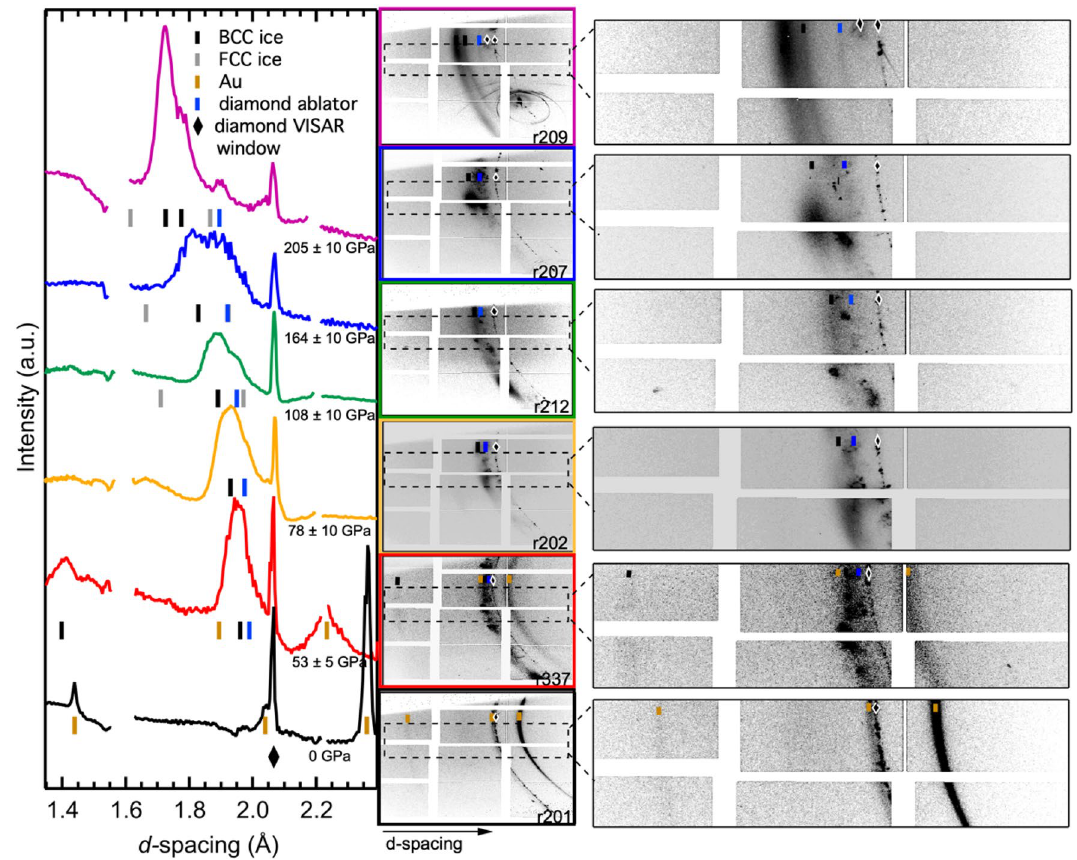
Figure 2. X-ray diffraction data with increasing pressure. Raw integrated traces from all high-pressure water shots without any normalization measured at ~ 7 ns for the highest pressures. Colored tick marks indicate fitted peak center for labeled phase. FCC ice positions are shown for reference to note where peaks would be predicted to appear, but are not observed, at these pressures. The sharp peak at 2.07 Å is the diamond peak (111) at near ambient conditions, labeled (filled diamond) from the VISAR-side window. r337 peak assignment is particularly complicated due to superposed peaks from diamonds and ice. However, due to the presence of the (200) ice peak near 1.4 Å we can constrain the ice (110) to be a component of the diffraction intensity seen at ~ 1.95 Å. Breaks between the detector pads are seen at d- spacings of 1.6 and 2.2 Å. Examples of 2-dimensional raw CSPAD images with colored ticks to match phases listed in traces are shown to the Diffraction from the (111) peak of the downstream diamond window shows little or no shift from the ambient d -spacing of 2.063 Å, indicating that the majority of the window volume is uncompressed. The lowest pressure XRD pattern records the Au (111) and (220) peaks shift to smaller d -spacing and broadening – providing a thermally corrected pressure of 47 ± 3 GPa, 1150 K (Ref. 17,18 ); Fig. 2, red trace. The ablator CVD (111) diamond peak is also resolvable and shifts, consistent with 53 ± 5 GPa compression 18–20 . Two new XRD features are seen